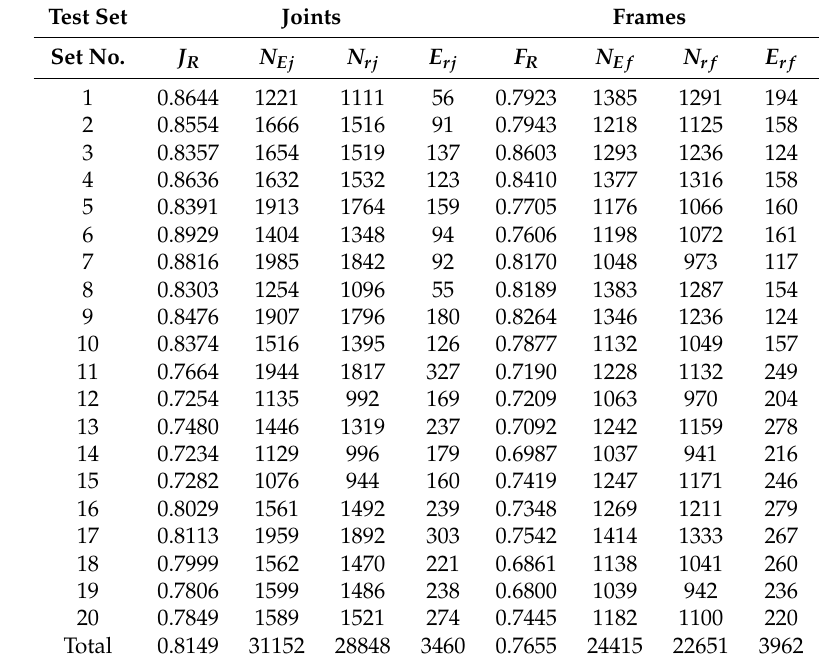
Table 1. Result of unreliable joint position redress. J R is the precisely recovered joint rate. F R is the precisely recovered frame rate. N Ej is the number of unreliable joints. N Ef is the number of frames affected by unreliable joints. N rj is the number of total recovered unreliable joint. E rj is the number of inaccurately recovered joints. N rf is the total number of recovered frames. E rf is the number of frames containing inaccurately recovered